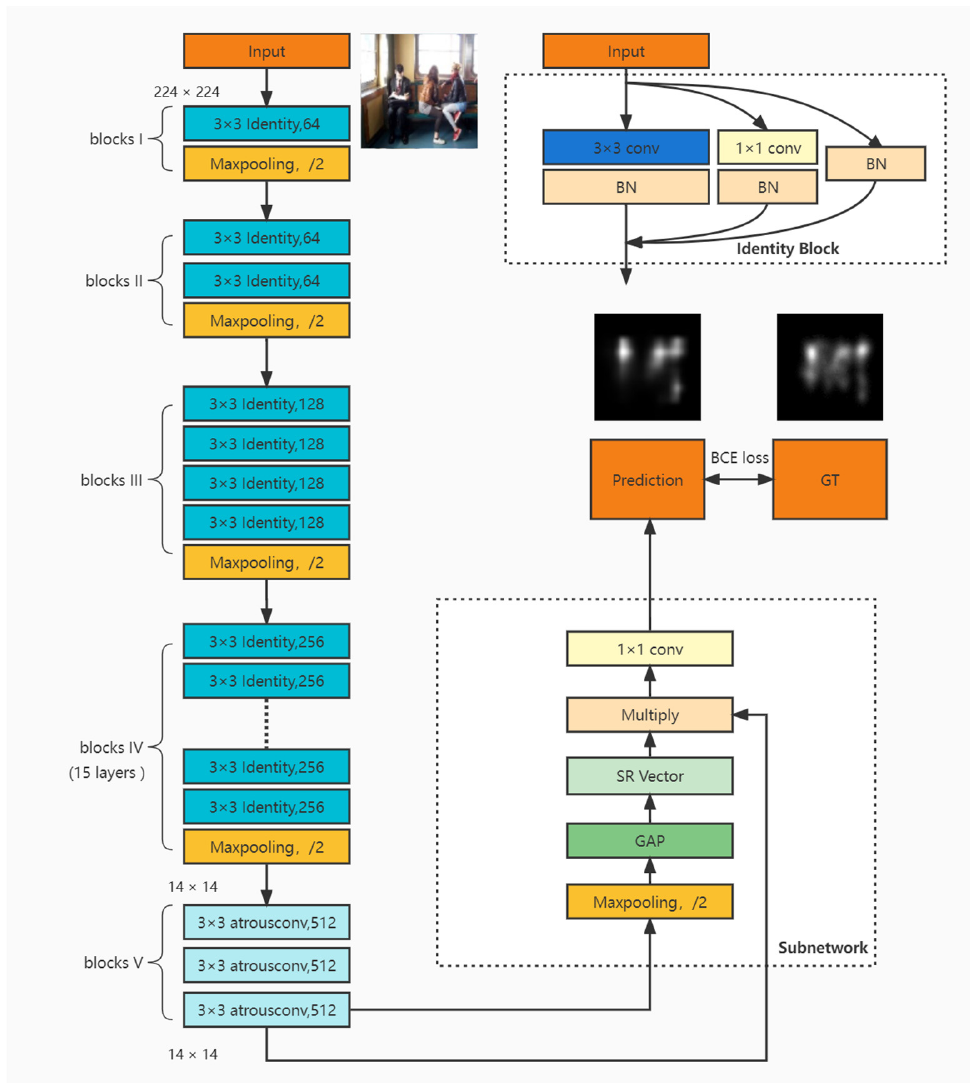
Figure 2. Overall network architecture.